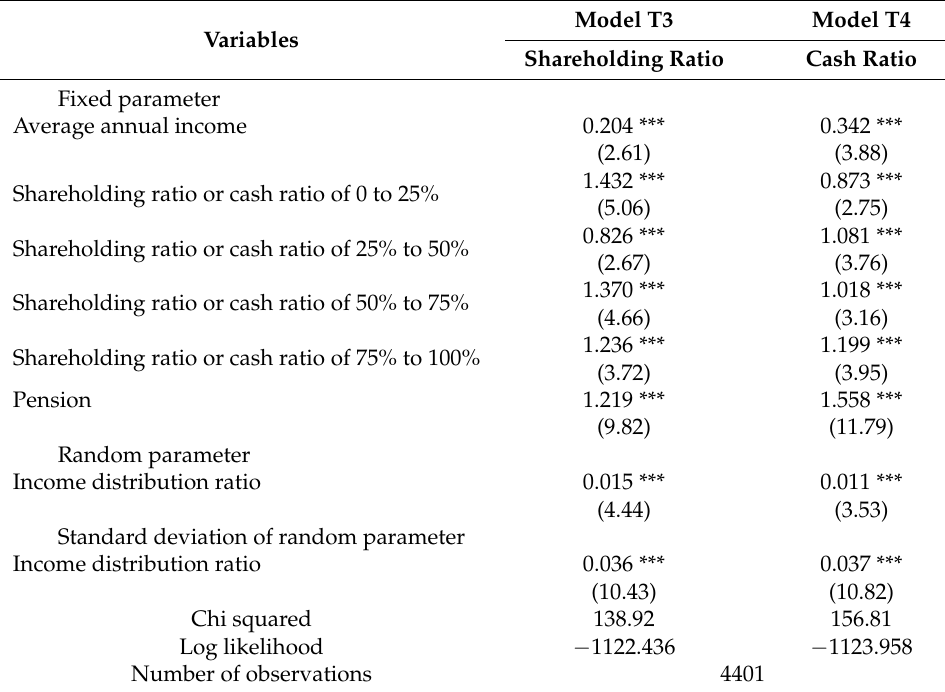
Table 7. Estimation results of random parameter Logit model based on total sample under sharehold- ing ratio or cash